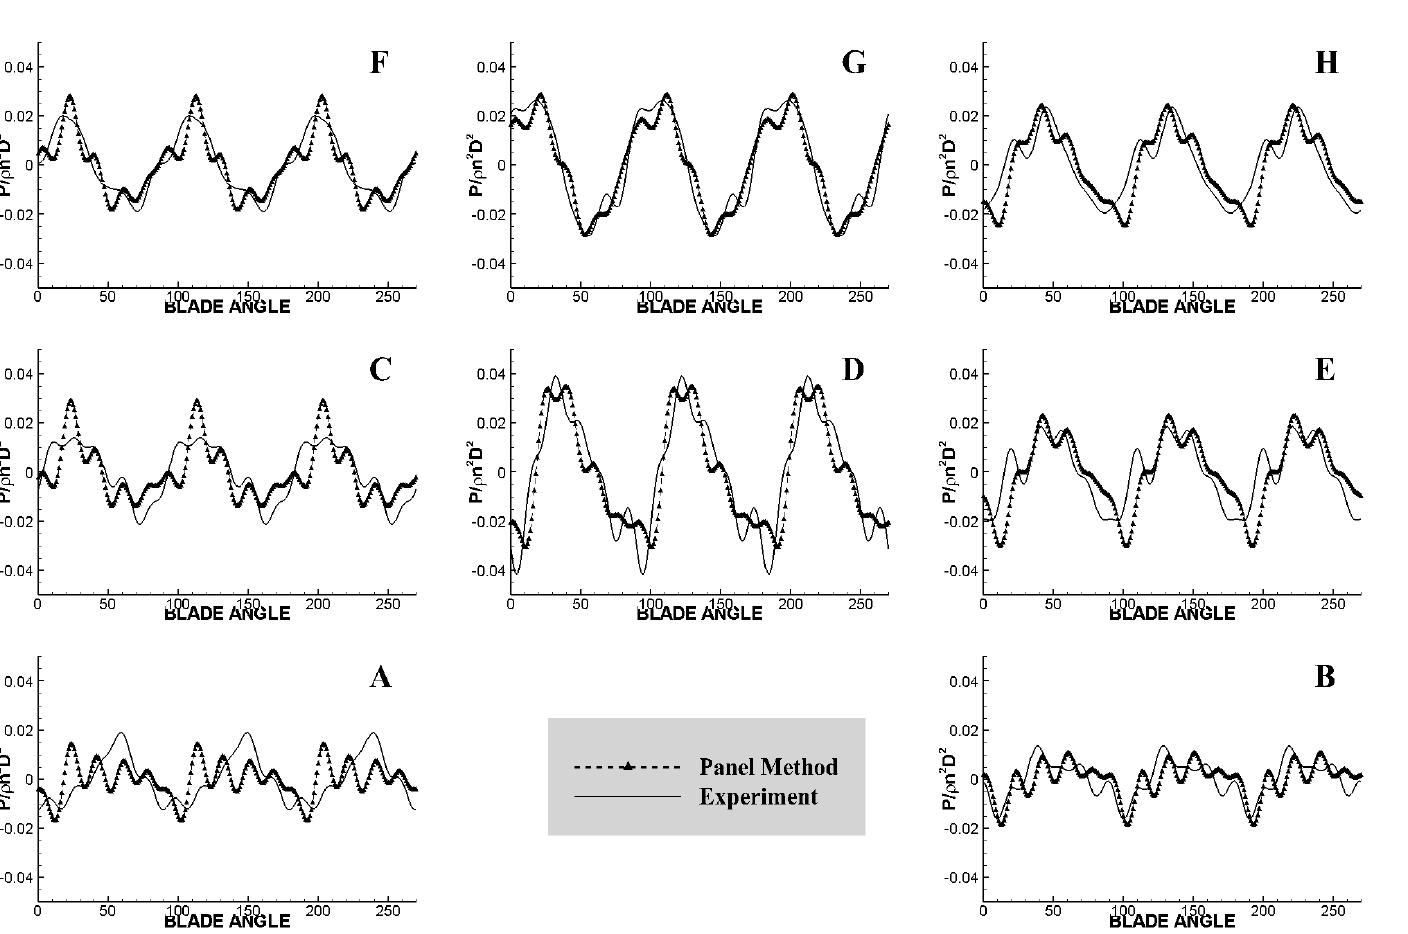
Figure 35. Comparisons of the hull pressures ( P / ρ n 2 D 2 ; y axis) in cavitating conditions between the pressure-BEM and the experiments during the three-fourths period of propeller revolution. Results are only shown between 0 ◦ to 270 ◦ in blade angle ( x axis). Locations of the transducers ( A – H ) are indicated in the